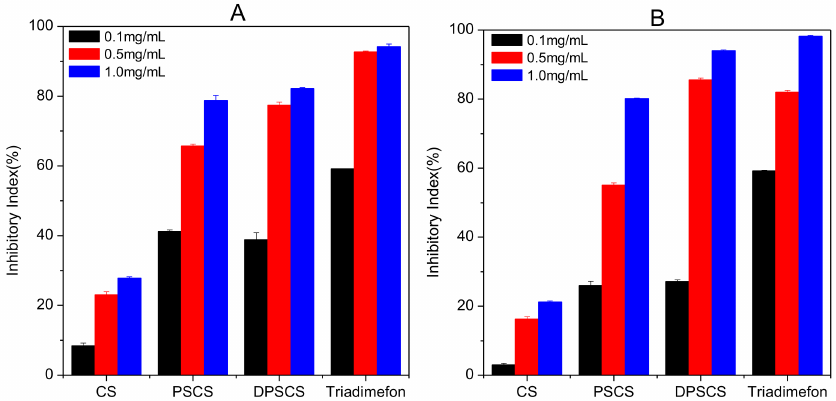
Figure 5. Antifungal activity against P. asparagi ( A ) and F. oxysporum ( B ) at 0.1, 0.5, and 1.0